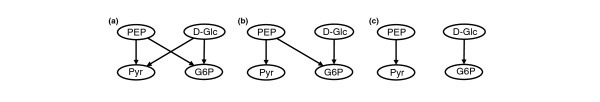
Metabolite graph representation of the PEP: Pyr uptake system of glucose. (a) Metabolite graph; (b) metabolite graph restricted to atomic exchanges; (c) metabolite graph restricted to carbon exchanges. D-Glc, glucose; G6P, glucose 6-phosphate; PEP, phosphoenolpyruvate; Pyr, pyruvate.